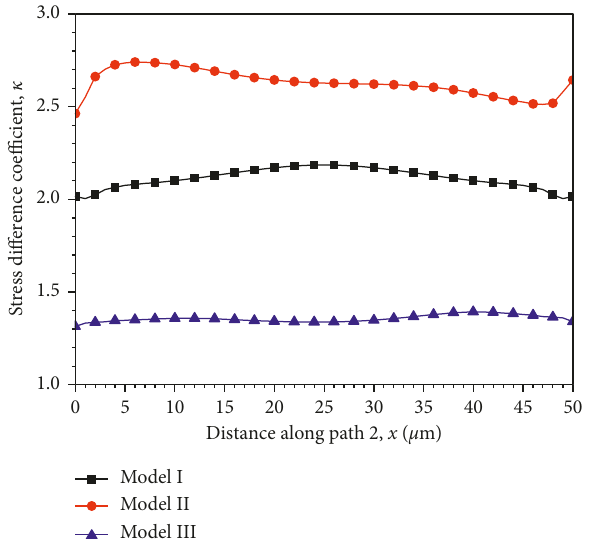
Figure 13: Mises stress difference coefficient along path 2.